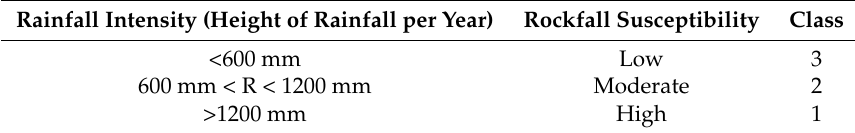
Figure 9. Thematic map of classification of rainfall intensity in Greece. Table 4. Rating of annual rainfall intensity.